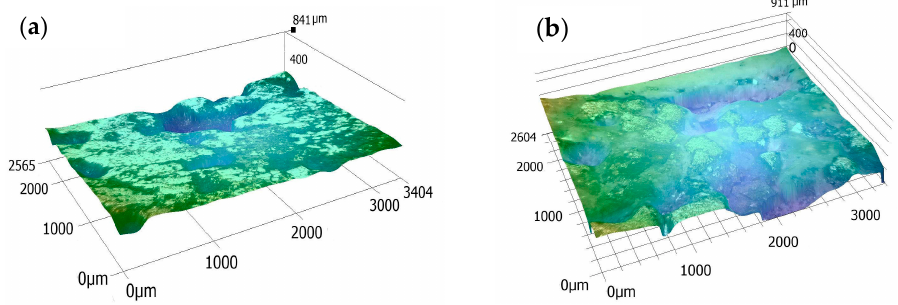
Figure 1. Micrograph of the polished surface in three dimensions:( a ) black sample, ( b )white sample.